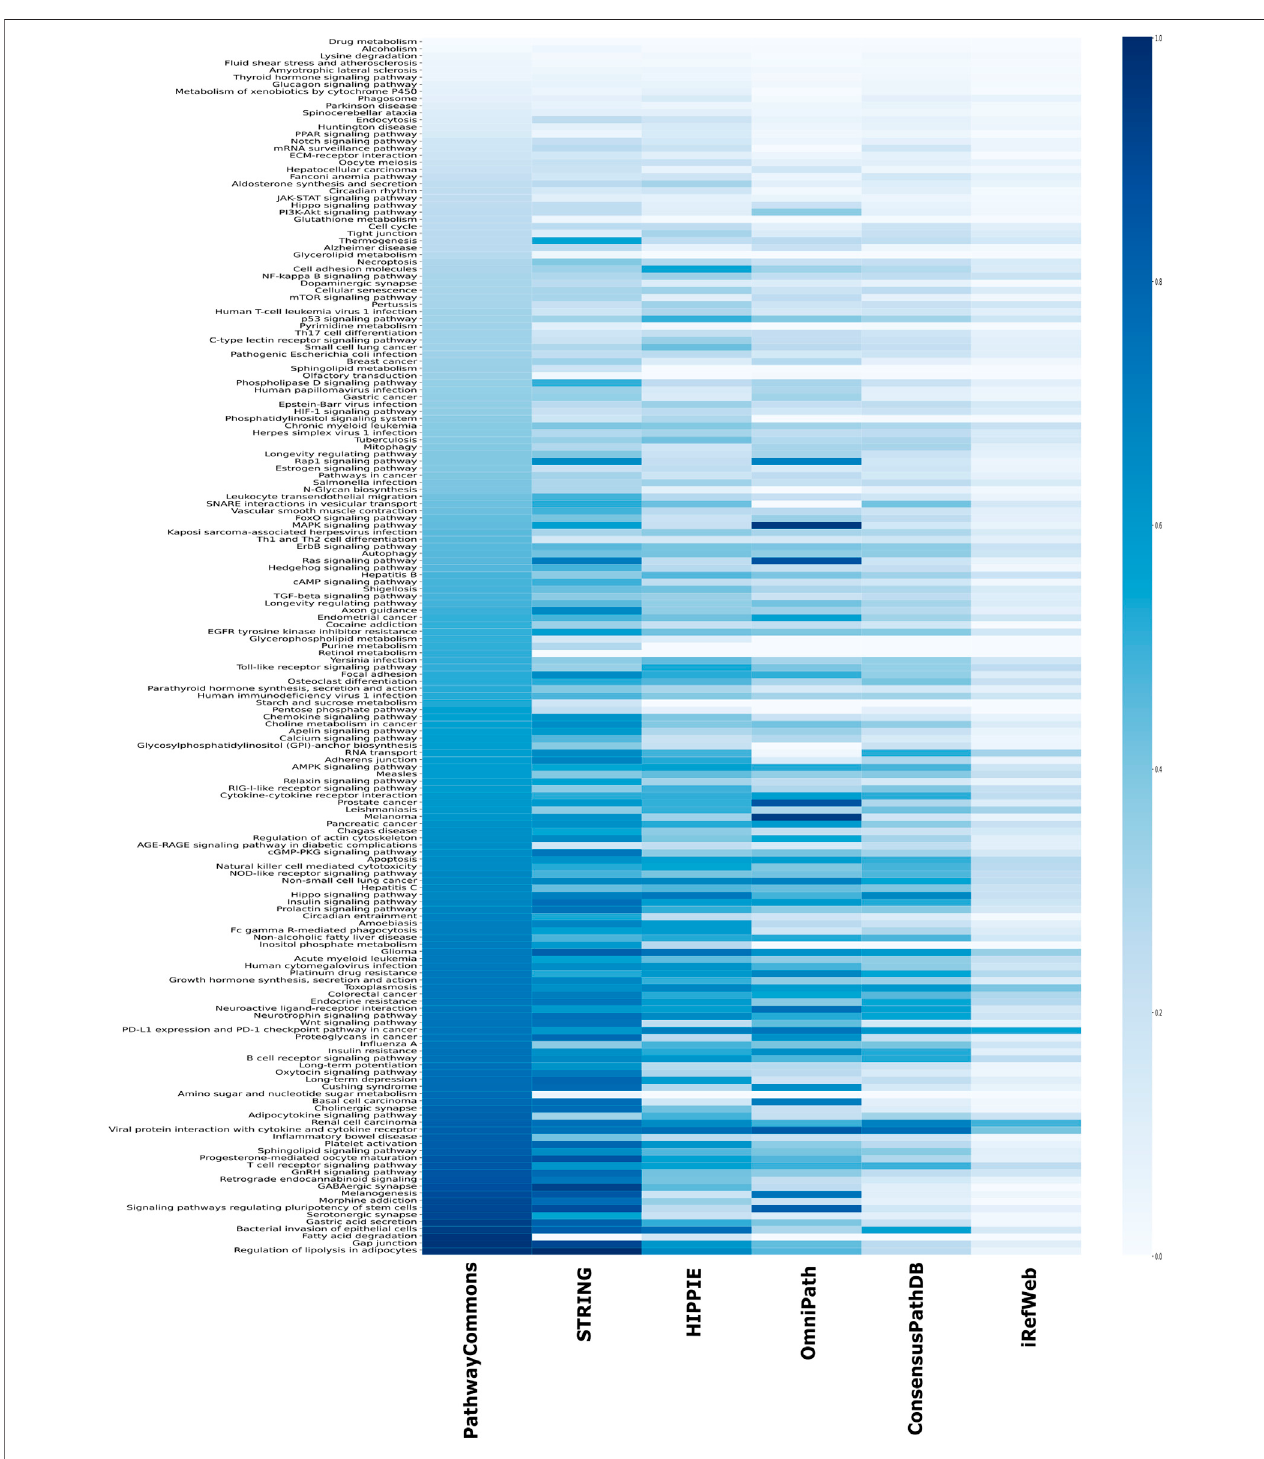
FIGURE5| OverlapbetweeneachpathwayinKEGGandeachinteractome.Thesortedcoverageofinteractomesfor171KEGGpathwaysisshownasaheatmap.